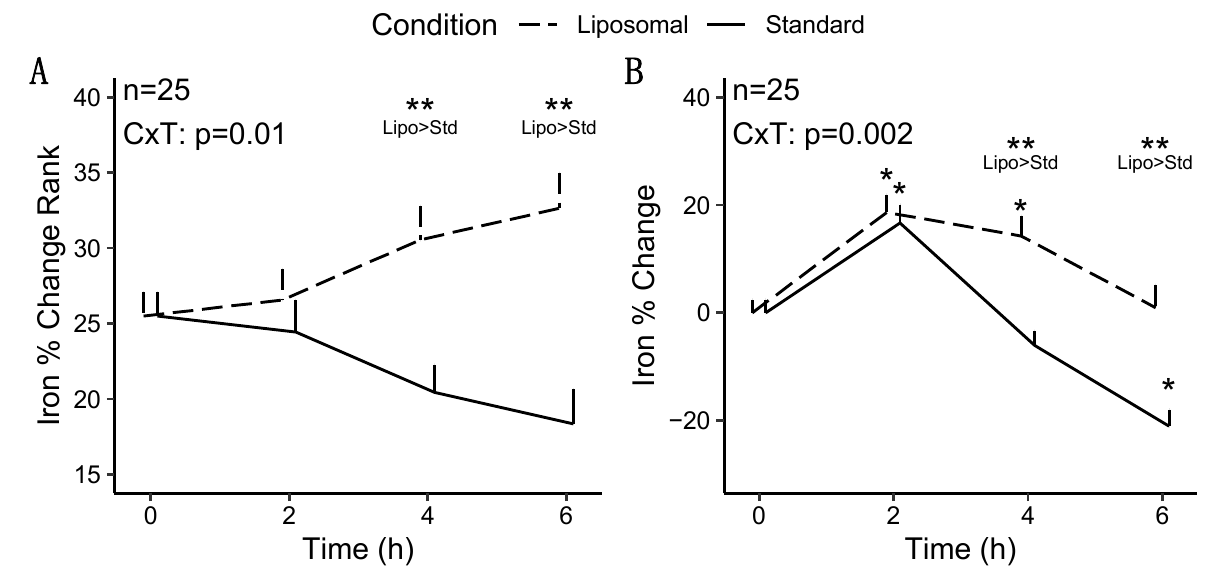
Figure 2. Changes in iron concentrations following multivitamin/mineral ingestion. The rank of percent changes from baseline ( A ) and percent changes from baseline ( B ) are presented. CxT indicates the p -value for the condition × time interaction. ** indicates a statistically significant difference between conditions at a particular time point. * indicates a statistically significant difference from baseline concentrations in a particular condition.